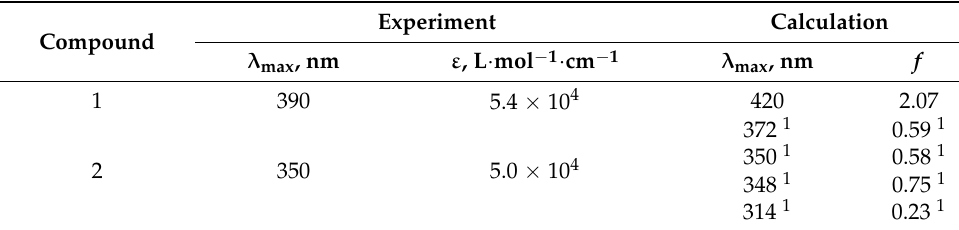
Table 1. Absorption band maxima and extinction coefficients.